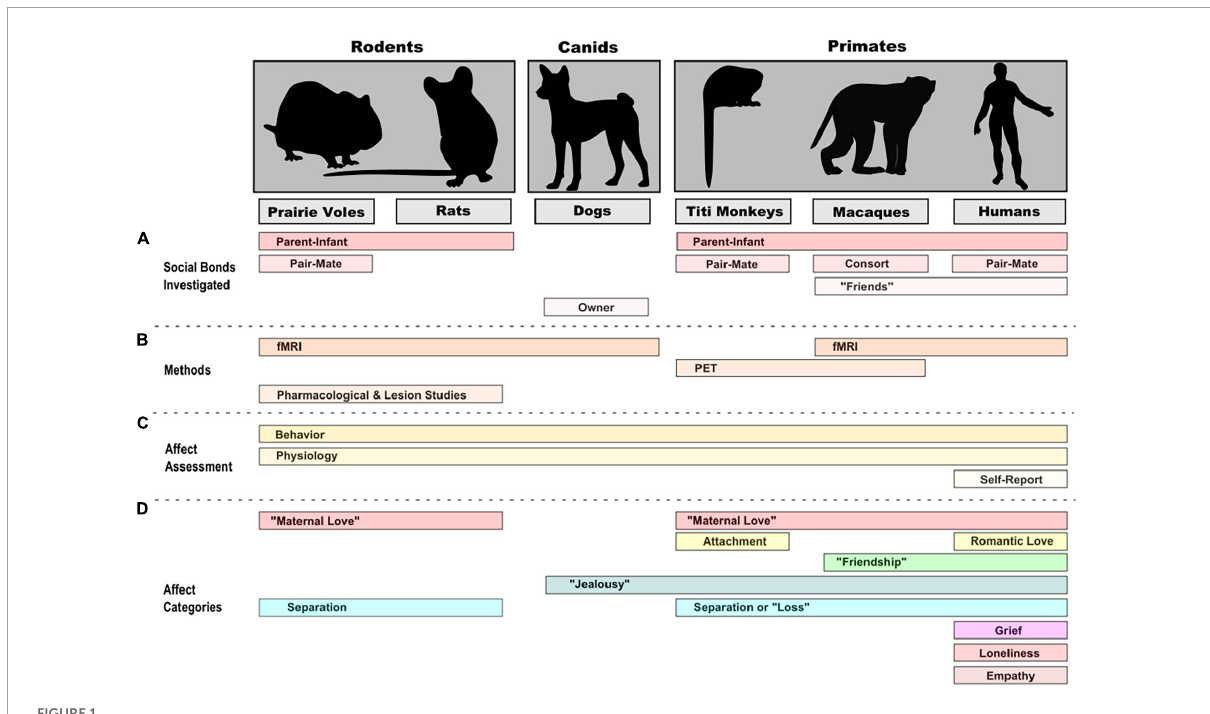
FIGURE1 Social contexts (A) , methods (B) , and levels of assessment (C) in neuroimaging and other complementary studies of emotion/affect (D) in representative rodent, canid, and primate